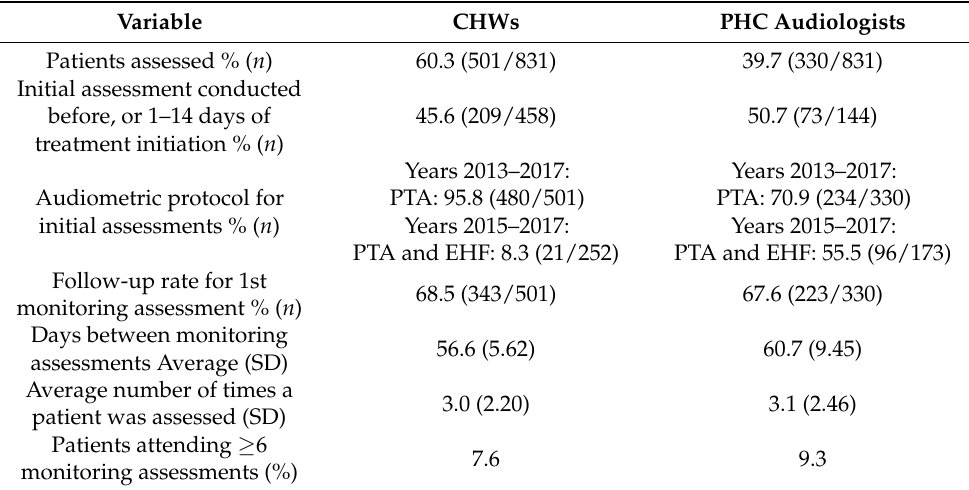
Table 4. Comparison of the audiometric protocol used, the timing and frequency of ototoxicity monitoring of patients assessed by CHWs and by PHC audiologists.